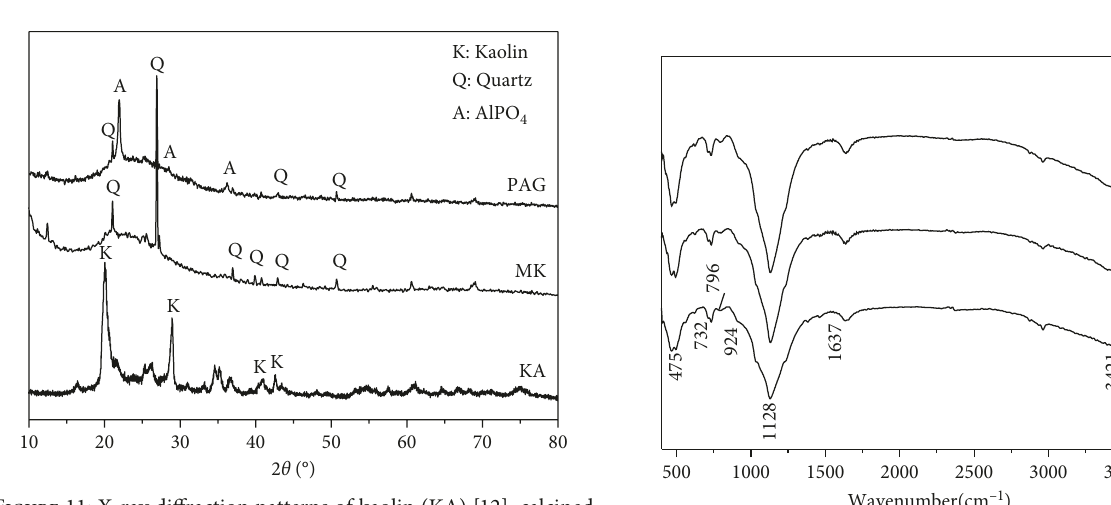
Figure 13: FTIR spectra of kaolin (KA) [12], calcined kaolin (MK) [12], and phosphate acid-based geopolymer (PAG).